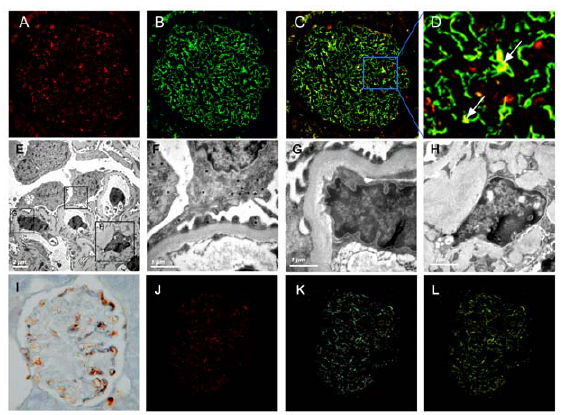
Figure 3. Simvastatin treatment in db/db mice. A–B: Dyslipid metabolism was significantly improved after treatment with Simvastatin in (A) serum cholesterol and (B) triglycerides. C: The levels of glucose were not changed. D: The levels of albuminuria were also remarked decreased in db/db mice. E: The fibronectin score on histology did not show a significant difference between db/db mice with and without Simvastatin treatment. F: The expression of H-FABP was significantly decreased in db/db mice with Simvastatin treatment compared to db/ db mice without Simvastatin treatment. G–J: histological changes were shown with Simvastatin treatment in (G) db/m mice, (H) db/db mice without Simvastatin treatment, (I) db/db mice with Simvastatin treatment and (J) quantitative changes in G / B ratio (ratio of glomerular and Bowman’s capsule volume) showed a remarked decrement in db/ db mice with Simvastatin treatment. Data are presented as the mean 6 SD. * P , 0.05; ** P , 0.01 versus db/db mice without Simvastatin treatment.